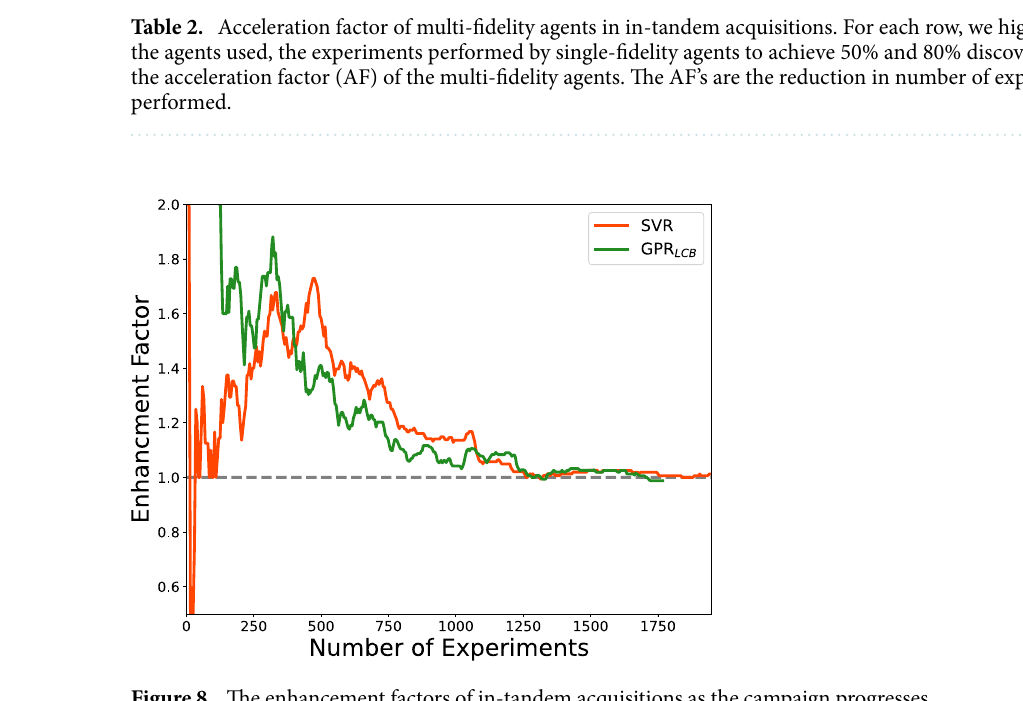
Figure 8. The enhancement factors of in-tandem acquisitions as the campaign